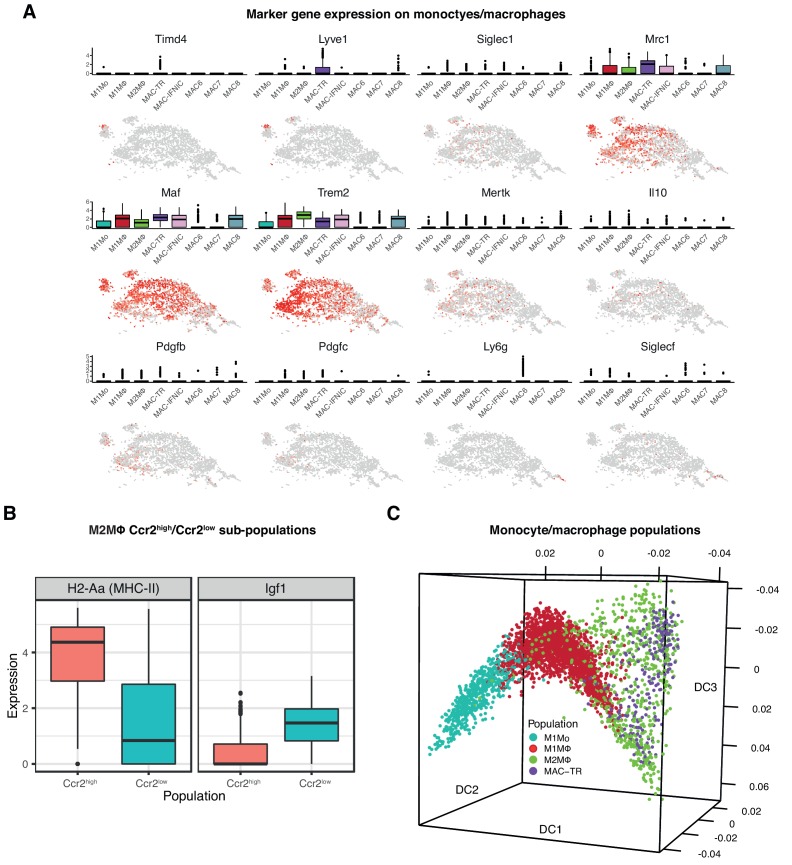
Mo and MΦ marker genes and Diffusion Map analysis.(A) Expression of selected genes marking Mo and MΦ sub-populations visualized using box and t-SNE plots. (B) Expression of H2-Aa (MHC-II) and Igf1 between sub-populations of M2MΦ defined according to Ccr2 expression (Ccr2high and Ccr2low) as visualized in box-plots. (C) Major Mo/MΦ populations visualized on diffusion components 1–3.